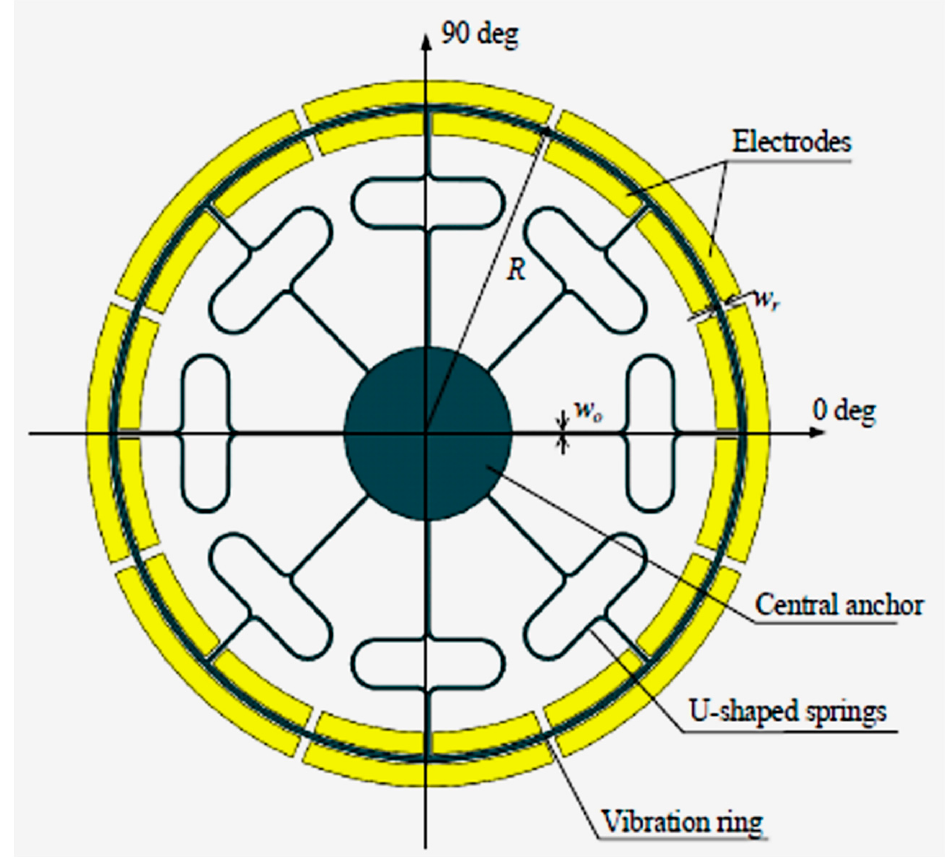
Figure 17. Schematic view of MEMS double U-beam vibrating ring gyroscope [56]. A novel design of a multi-ring vibrating gyroscope was established in [57]. The design had two sets of ring structures: internal rings and external rings. The multiple rings enhanced the sensitivity. The ring structure with C-shaped support springs was connected to the outer-placed fixed anchor. The proposed design of the multi-ring vibrating gyroscope is shown in Figure 18. The simulated resonant frequency was 40.40 kHz. However, when the device was characterized, the measured resonant frequency was 36.67 kHz. The difference between the designed and tested resonant values was less than 4.0 kHz. The reason for the discrepancy was microfabrication errors such as critical dimension losses and sidewall